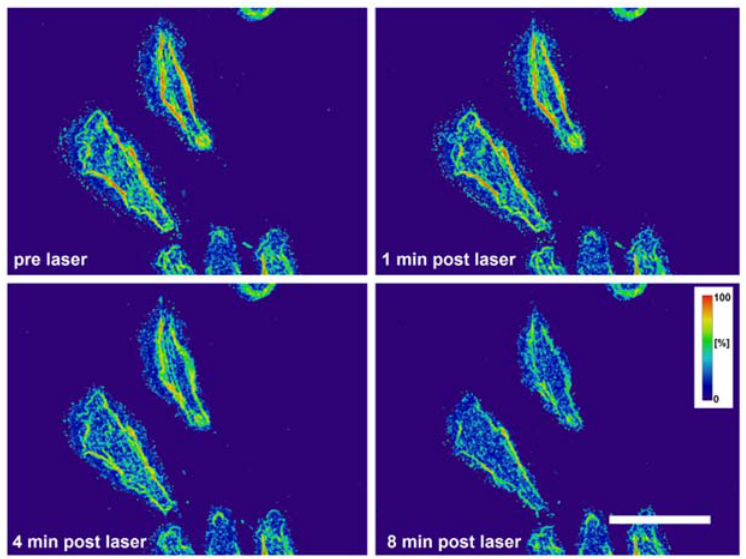
Fig 8. Time series showing the coherency of F-actin in irradiated ZMTH3-Act cells. For visualization a mean filter of three pixels was applied. A coherency of 1 means a high degree of orientation of local image features. A coherency of zero indicates no orientation. Laser parameter: 10 ms irradiation time and radiant exposure of 41 mJ/cm 2 . Scale bar 50 μ